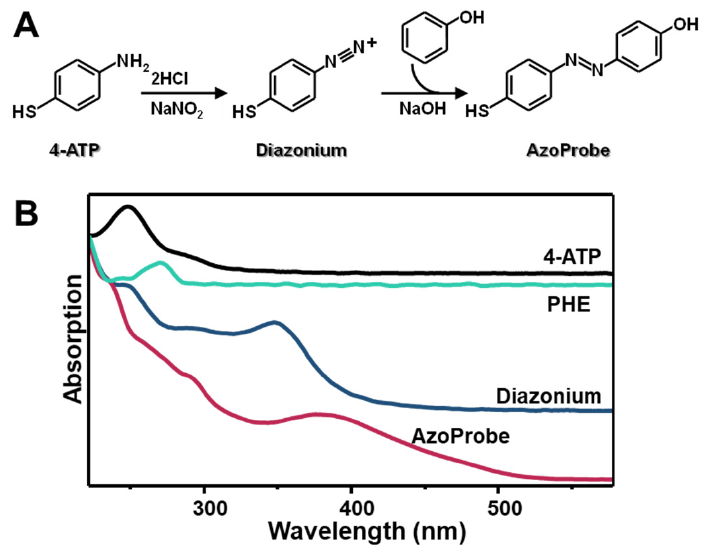
Figure 1. ( A ) Outline of the synthetic route for mercaptophenyl azo phenol (AzoProbe) preparation. ( B ) UV-Vis spectra of the precursors 4-aminothiophenol (4-ATP) and phenol (PHE), the in situ generated diazonium cation and the AzoProbe reaction mixture.